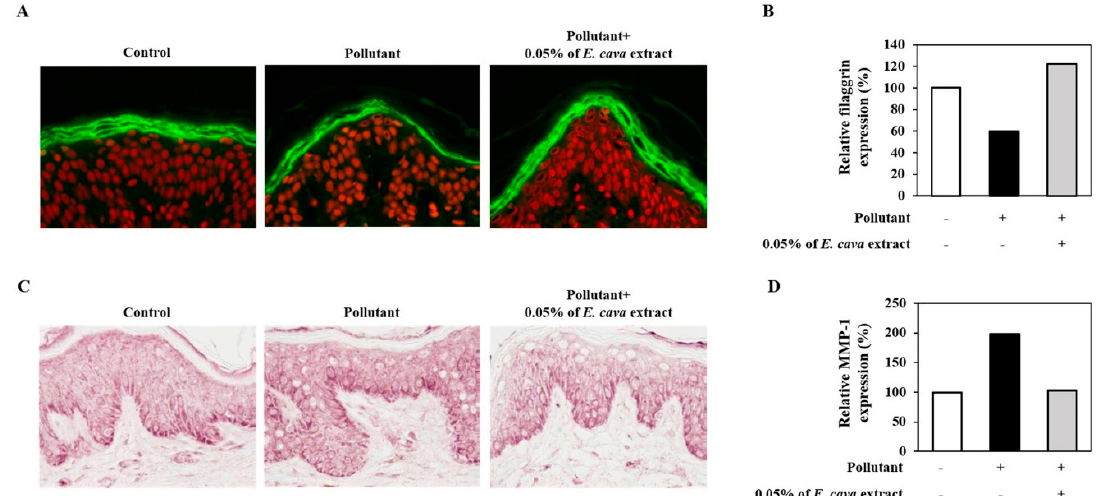
Figure 3. Effect of E. cava extract on filaggrin and MMP-1 expression conducted in living human skin explant models affected by pollutants. A mixture of heavy metals and hydrocarbon induced loss of filaggrin which was recovered by treatment with E. cava extract confirmed in immunostaining microscopic images ( A ) and quantified in ( B ). Pollutant induced expression of MMP-1 was confirmed under the same conditions. Expression of MMP-1 was significantly decreased by E. cava extract ( C ) and quantified in graph ( D ). All staining results were evaluated using image J program.